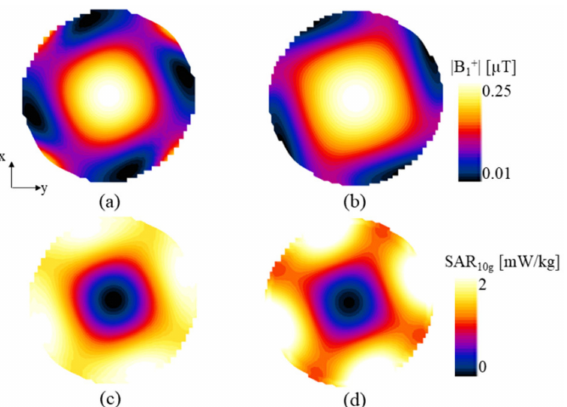
Figure 5. Computed |B 1+ |-field for the ( a ) BC and ( b ) t-MTL array. SAR maps for the ( c ) BC coil and ( d ) t-MTL